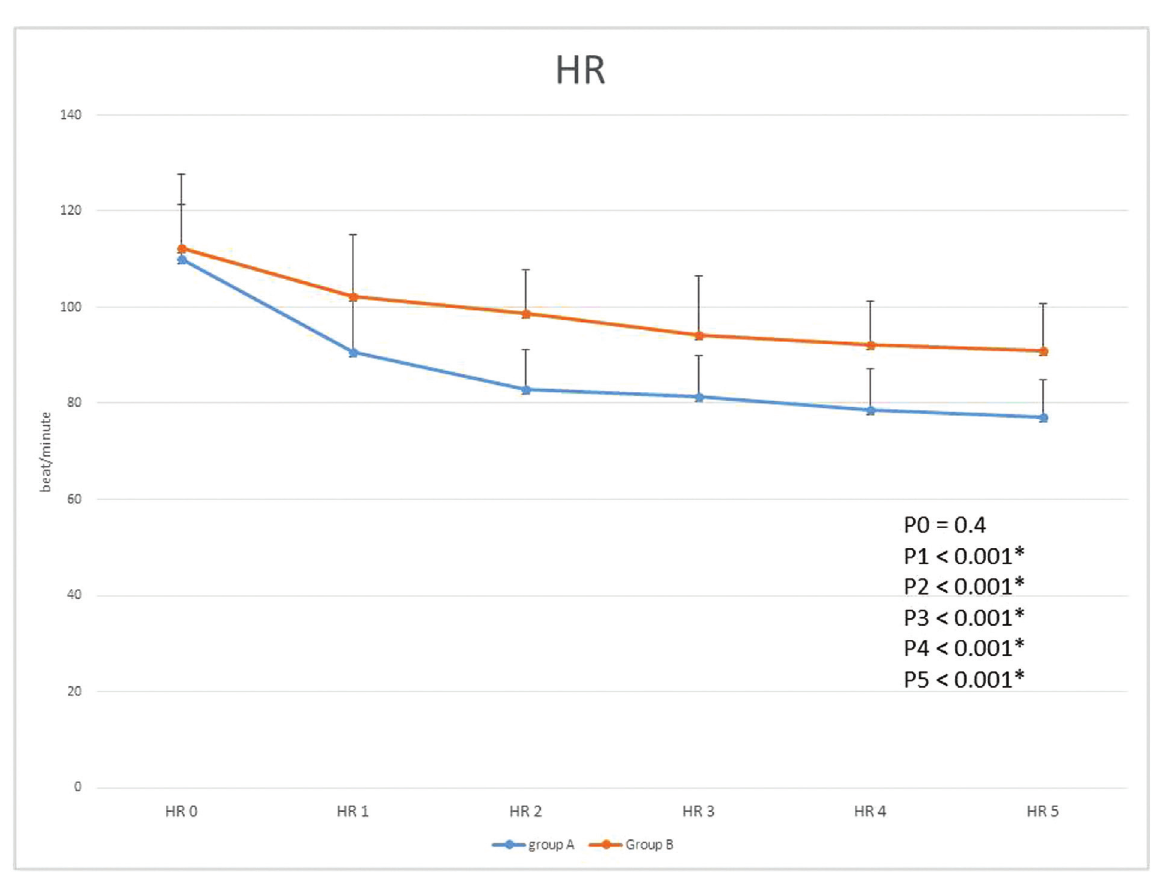
Effect of sedation on HR. HR: heart rate. Data are expressed as mean±SD. Group A: sedation group. Group B: no-sedation group. P value less than 0.05 is considered statistically significant. HR_0 = baseline heart rate at intubation, HR_1 = heart rate 1h after intubation, HR_2 = heart